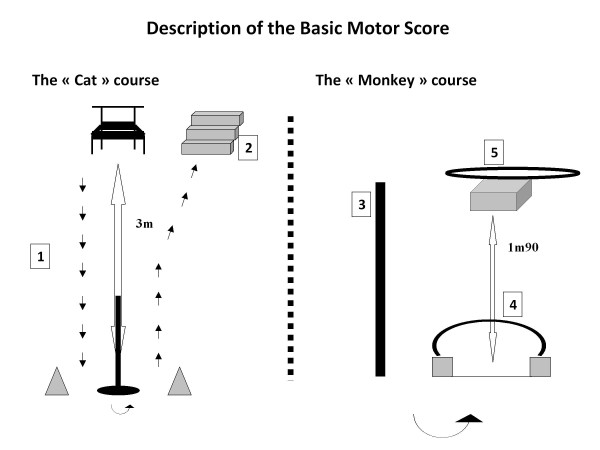
Description of the Basic Motor Score. 1Running, 2Climbing up and down the stairs, 3Balancing, 4Getting up, 5Landing after jumping.